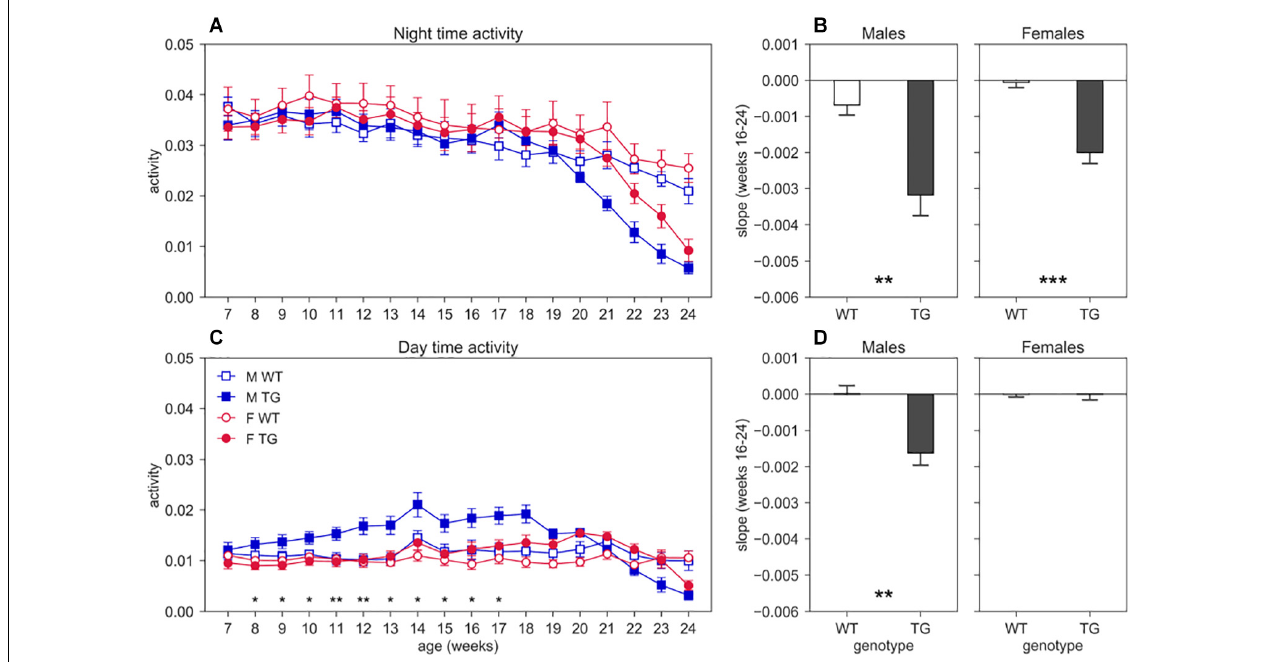
FIGURE 3 | Night and day time activity. Average weekly activity ( ± SEM) over night (A) and day (C) time across 7–24 weeks of age in male (M, blue squares) and female (F, red circles) cages of WT (open symbols) and SOD1G93A (TG, filled symbols) mice. N of cages per group: M WT = 8; M TG = 9; F WT = 11; F TG = 10. We found no significant D/AP post-hoc test (until week 20) when comparing day activity between WT and TG with both males and females. Since we found a significant Genotype X Sex X Age interaction for day time activity (nparLD test, Genotype X Sex X Age interaction: Statistic = 2.356, df = 4.161, p < 0.05) we compared TG males with TG females with D/AP post-hoc procedure in C (* p < 0.05, ** p < 0.01, black stars). We observed a clear decreasing trend of day and night activity in TG mice compared to WT, but we could not perform tests after week 20, since some cages were missing. Panel (B) shows the slope of the linear regression computed for the weekly night time activity points in weeks of age 16–24, while panel (D) shows the results for day time activity. (** p < 0.01, *** p < 0.001 two sample T